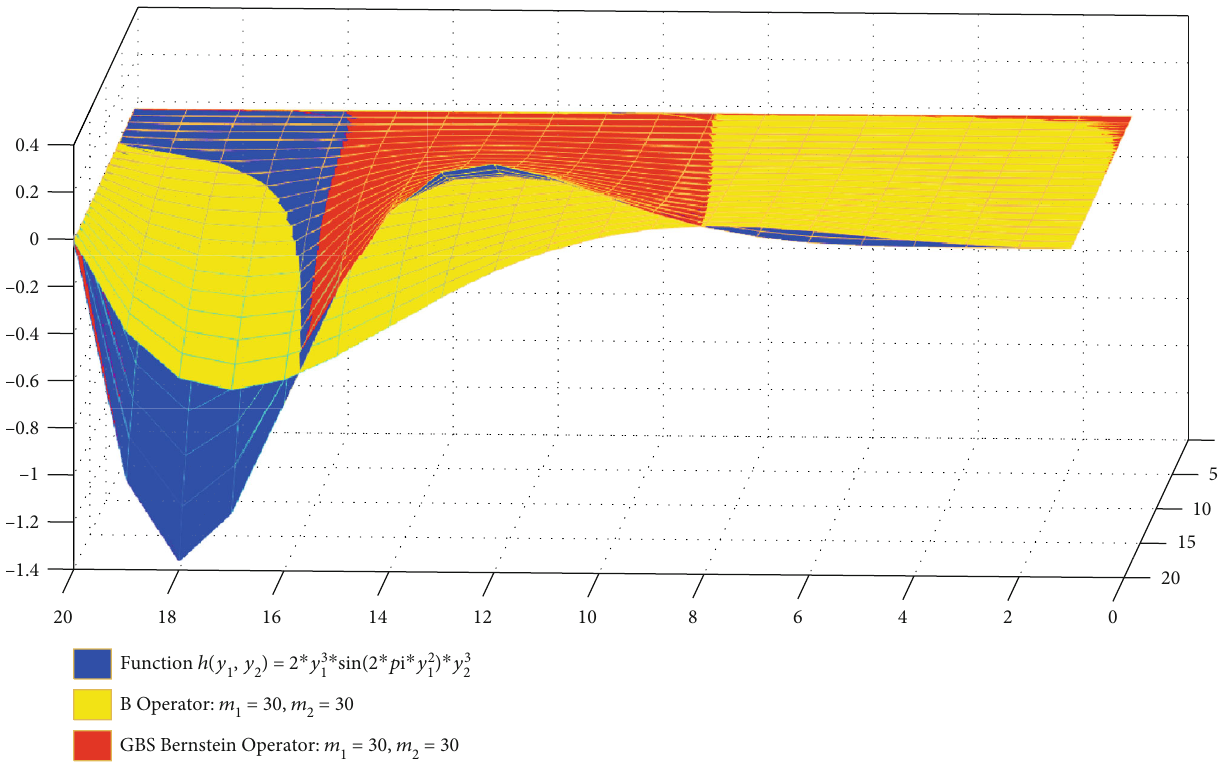
Figure 3: The convergence of GBS ð 0 : 6